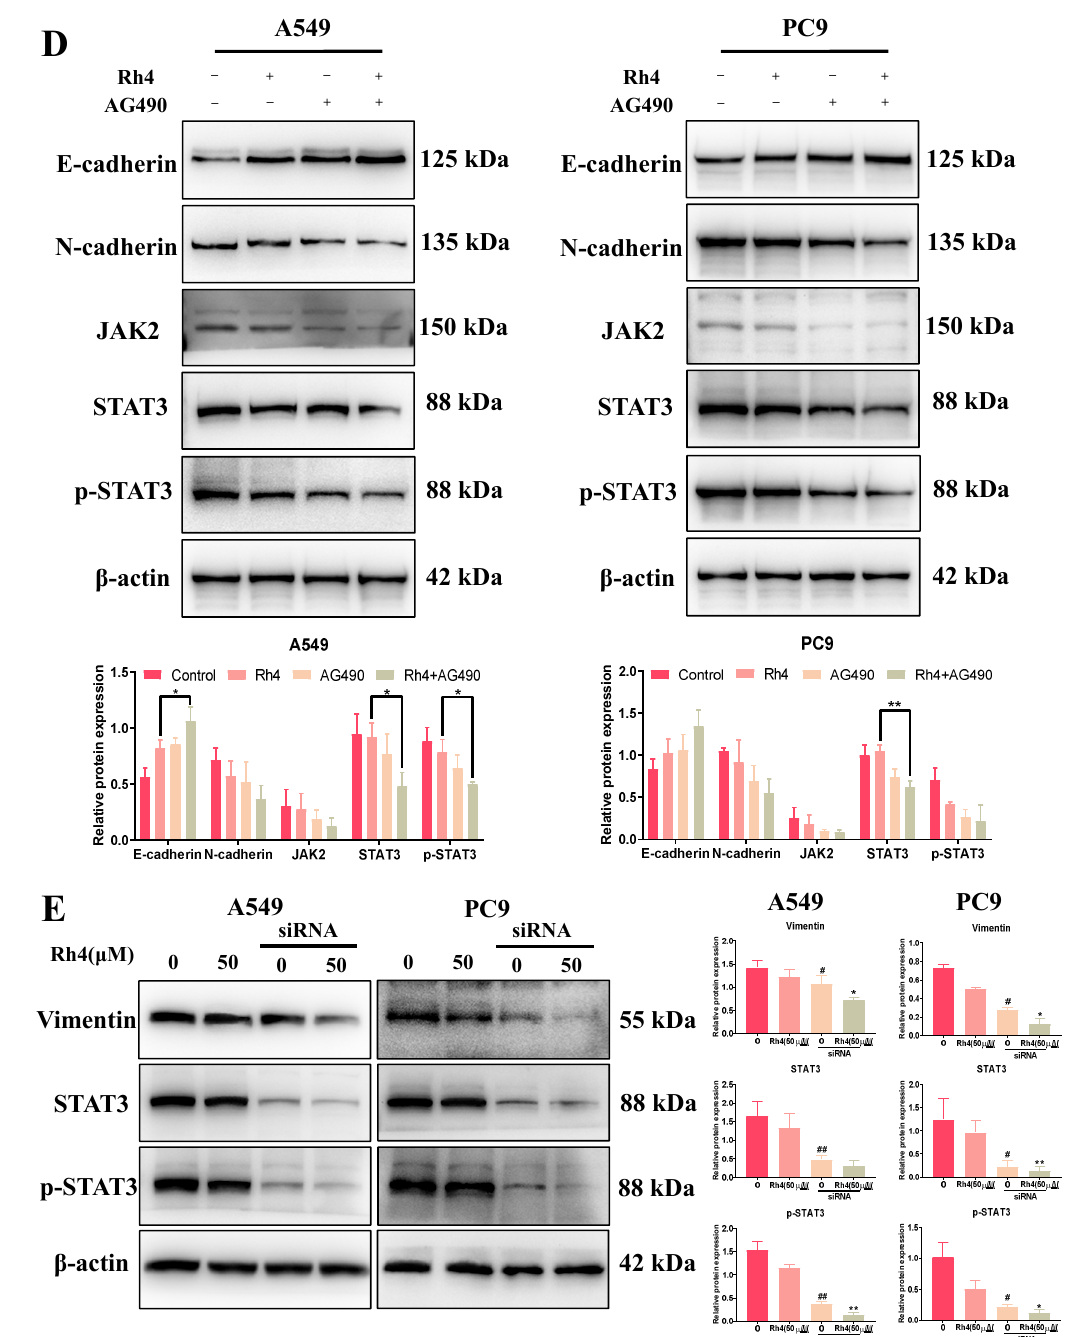
Figure 7. Ginsenoside Rh4 attenuated JAK2/STAT3 signaling pathway of LAC in vivo and in vitro. ( A ) Western blot analysis. Rh4 inhibited the upregulation of JAK2, STAT3 and p-STAT3 by TGF- β 1 in LAC cells from Western blot analysis. ( B , C ) Rh4 decreased the expression of JAK2, STAT3 and p-STAT3 in vivo, which were detected by Western blot ( B ) and immunohistochemistry staining ( C ). ( D ) Western blot analysis. The effect of Rh4 combined with AG490 on expressions of EMT biomarkers and JAK2/STAT3 proteins in LAC cells (A549 and PC9). ( E ) Western blot analysis. The effect of Rh4 combined with STAT3 siRNA expressions of EMT biomarker in LAC cells (A549 and PC9). β -actin was used as an endogenous reference. n 1 , n 2 and n 3 represent three different mice in each group. There were 5 mice in each group. Scale bars = 100 µ m. Data are presented as mean ± SD of three independent experiments, # p < 0.05, ## p < 0.01 and ### p < 0.001compared with the negative control, * p < 0.05, ** p < 0.01 and *** p < 0.001 compared with the TGF- β 1 (5 ng/mL) group ( A ) or Rh4 group ( E